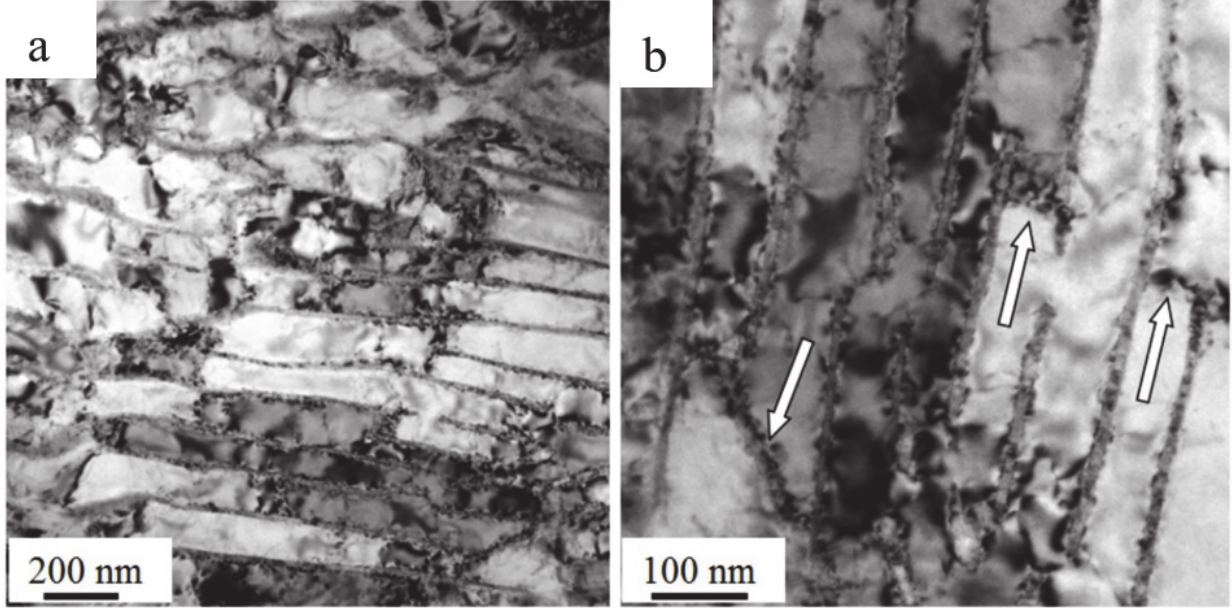
Figure 2. A TEM image of the steel at ε = 50%. ( a )–fragmented structure; in ( b ) arrows indicate the low-angle boundaries being present in the ferrite plates of a pearlite colony. Simultaneously, with that in the ferrite plates, the fragments of cementite plates (Figure 3), whose sizes varied in a range between 15 and 20 nm and depend weakly on the degree of deformation, were